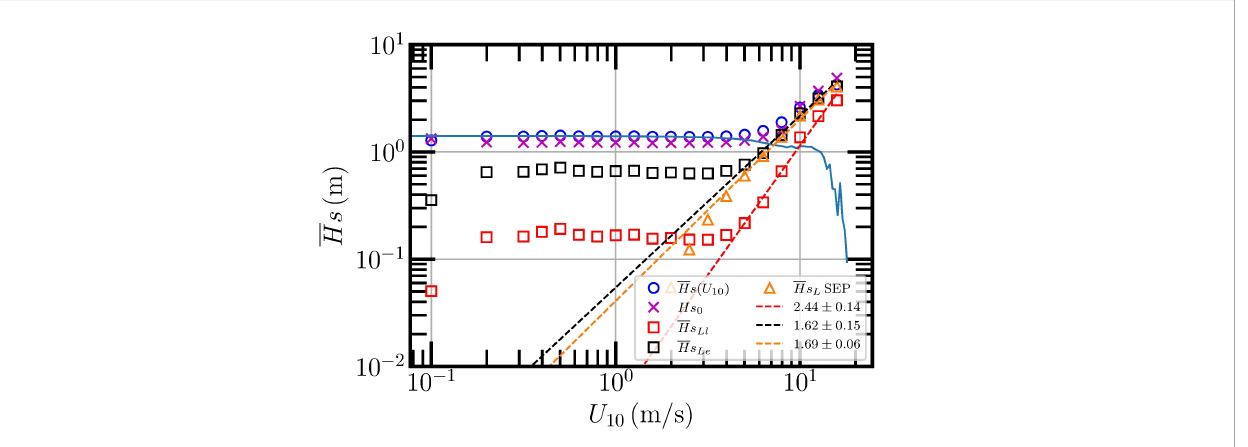
FIGURE 5 Comparison of the measured skeleton (cid:1) Hs 0 ( U 10 ) (× ) for the joint PDF of U 10 and Hs provided by the NDBC buoy 46086. The extracted local signi fi cant wave heights (cid:1) Hs Ll ( U 10 ) and (cid:1) Hs Le ( U 10 ) by the probability-based approach is illustrated as □ . For comparison, the swell signi fi cant wave height (cid:1) Hs sw ( U 10 )